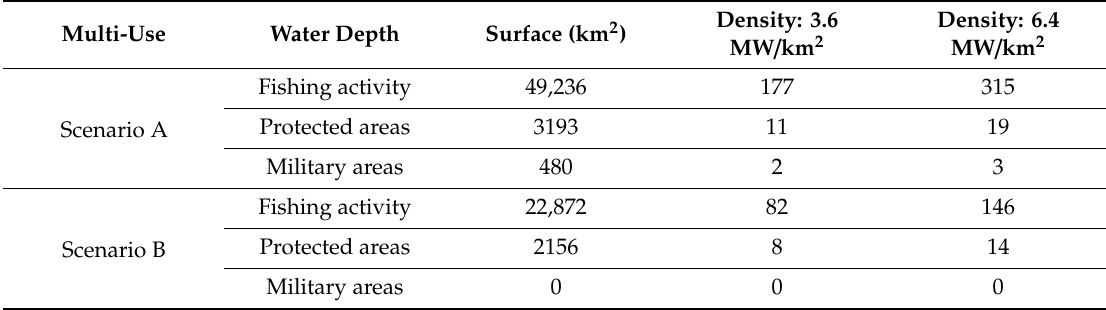
Table 15. Available space (km 2 and estimated GWs): multi-use of space in Scenarios A and B.